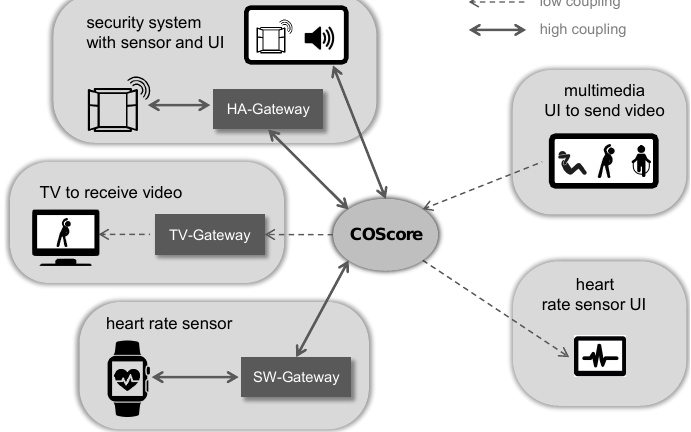
Figure 4. Connection of cyber-physical systems in a smart home